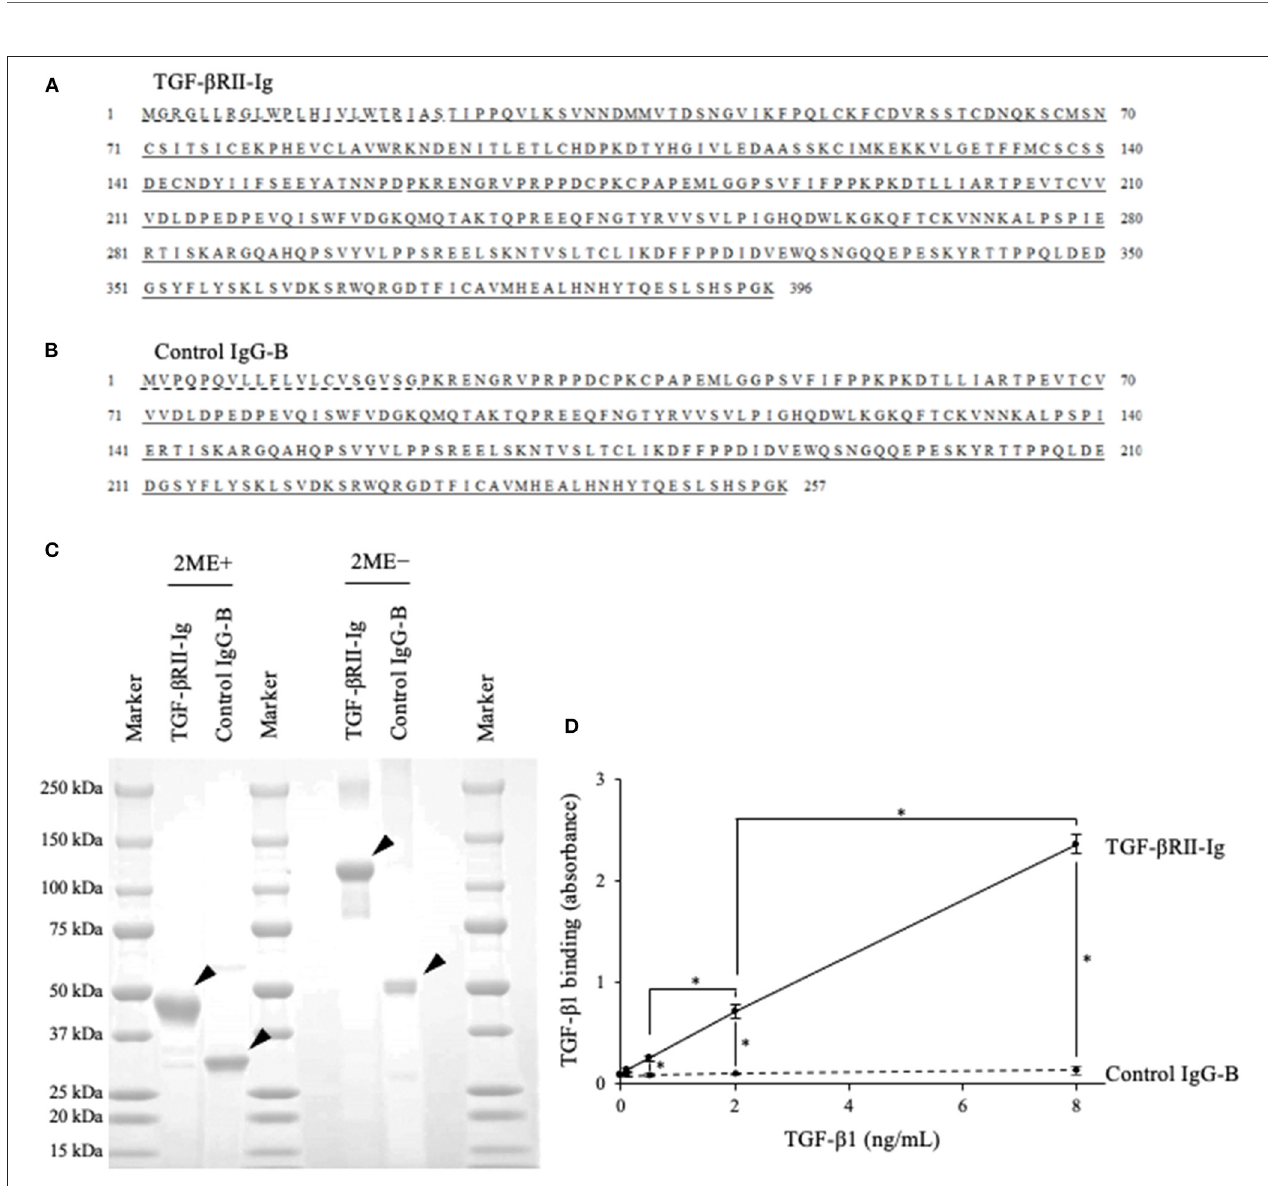
FIGURE 4 | Preparation of recombinant TGF- β RII-Ig and Control IgG-B. (A) The amino acid sequences of TGF- β RII-Ig. The predicted signal peptide of TGF- β RII, extracellular region, and canine IgG-B Fc region are marked with a dashed line, underline, and double underline, respectively. (B) The amino acid sequences of Control IgG-B. The signal peptide of the canine antibody light chain and canine IgG-B Fc region are marked with a dashed line and double underline, respectively. (C) SDS-PAGE of the purified Ig proteins. Analysis in reducing (left) and non-reducing (right) conditions. Arrowheads indicate the protein bands with expected molecular weights. (D) Binding of TGF- β RII-Ig to TGF- β 1. Each dot represents the average of absorbance obtained from three independent experiment. Error bars represent the standard deviation. One-way ANOVA with post-hoc Tukey’s-test was used for statistical analysis (* p <